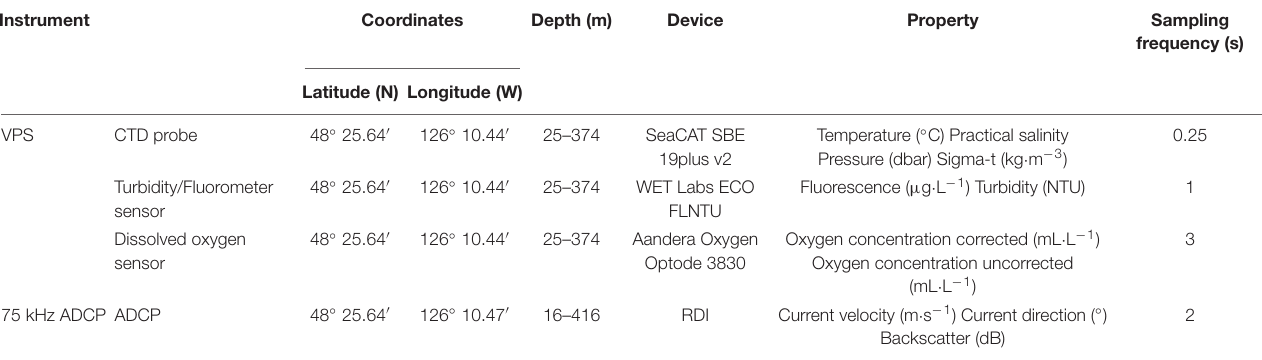
TABLE 1 | Summary of all instruments used from the Barkley Upper Slope (BUS) Instrument platform, including the Vertical Profiling System (VPS) and the low-frequency 75 kHz Acoustic Doppler Current Profiler (ADCP) used in this study, spanning from the 14th of August to the 23rd of November 2018.